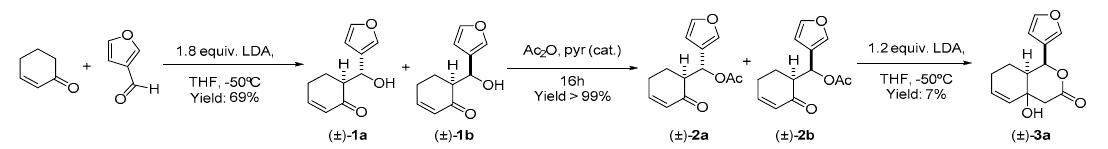
Scheme 2. Synthesis of model molecules 1 – 3 .